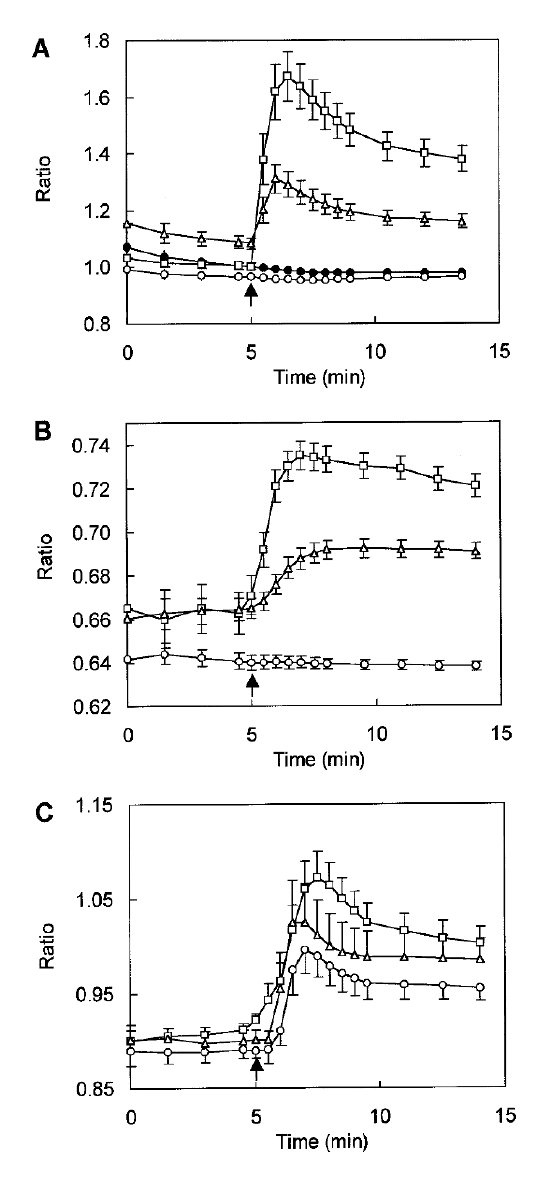
Changes of [Ca 2+ ] i level in NIH-3T3, HeLa and SaOS-2 cells following ethylene treatment. A. NIH- 3T3 cells were treated with 0.1 mM ( (cid:1) ), 0.3 mM ( mM ethephon ( (cid:3) ) 5 min after starting the experiment. In one control experiment, 0.5 mM of H HeLa cells were treated with 0.3 mM ( (cid:1) ), 1 mM ( mM ethephon ( (cid:3) ) 5 min after starting the experiment. C. SaOS-2 cells were treated with 0.3 mM ( (cid:1) ), 1 mM ( mM ethephon ( (cid:3) ) 5 min after starting the experiment. The values for the ratios of the 340/380 nm images are shown. The arrows mark the time at which ethephon was added to the cells. The results are expressed as mean values ± S.E.; n =